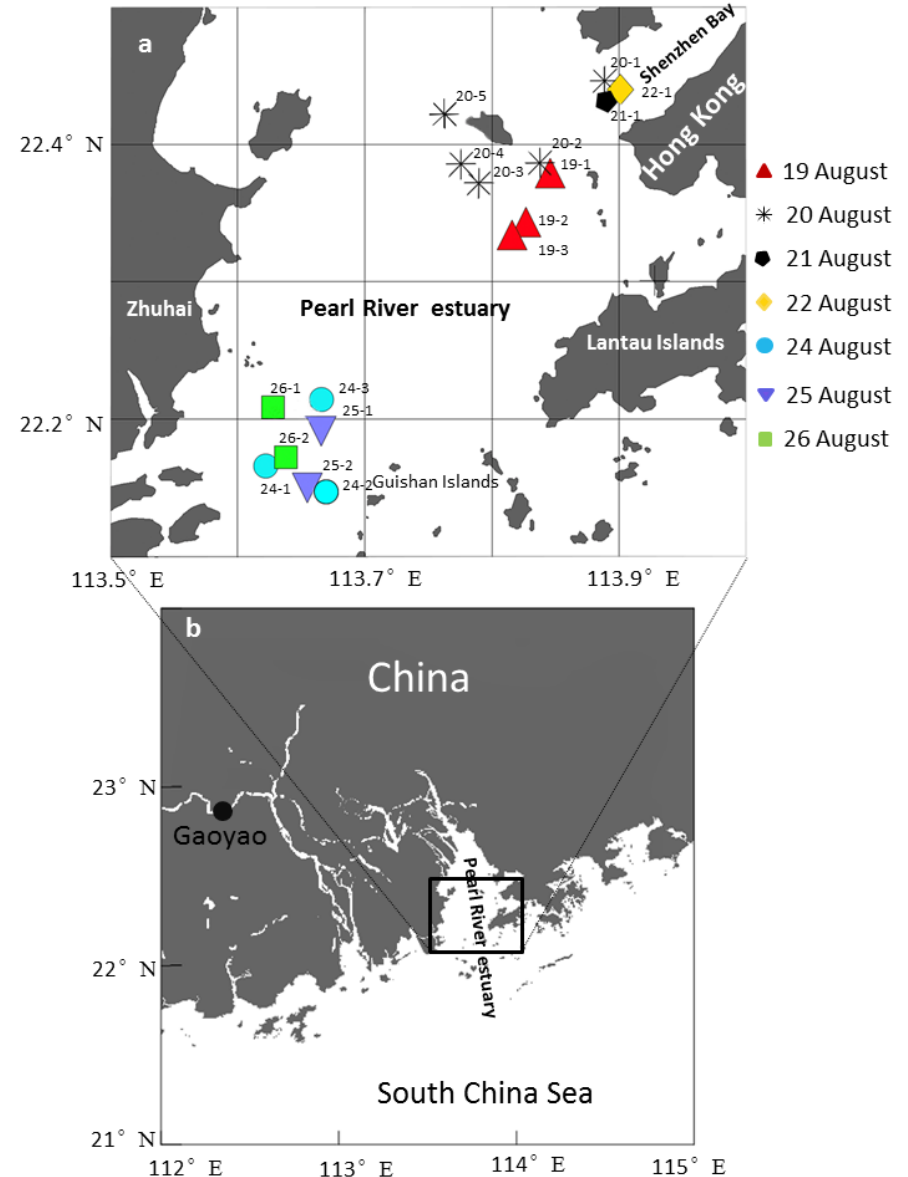
Figure 1. Sampling locations ( a ) and study area ( b ): Pearl River Estuary, August 2011.